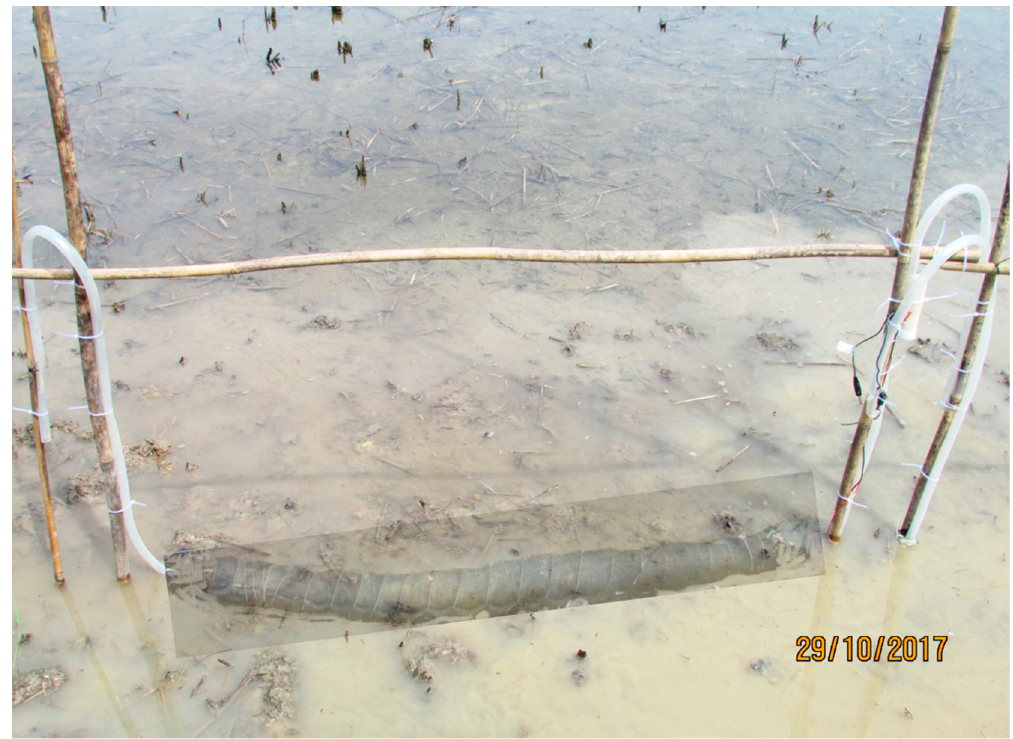
Figure 3. Installed tubular Plant-MFC installation (see shaded area) just before covering the tube with paddy field soil.